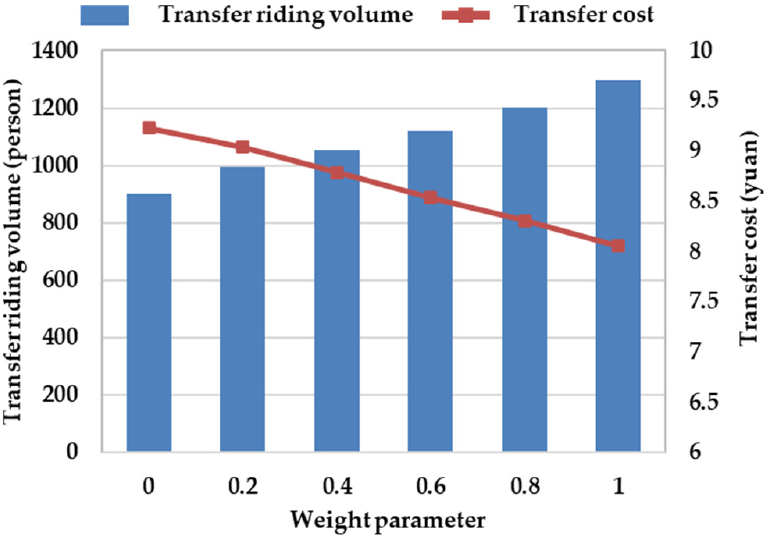
Figure 8. Sensitivity analysis of transfer-ride volume with target